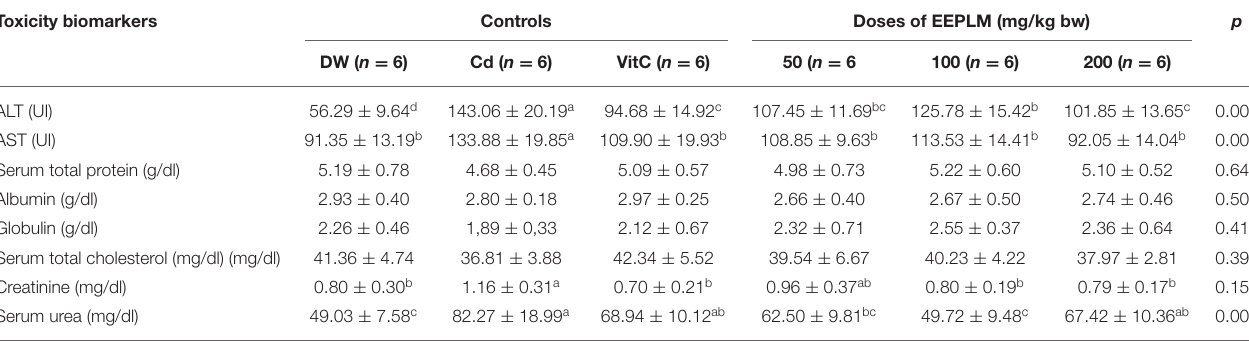
TABLE 4 | Effects of EEPLM on toxicity biomarkers in male guinea pigs exposed to cadmium chloride. Toxicity biomarkers